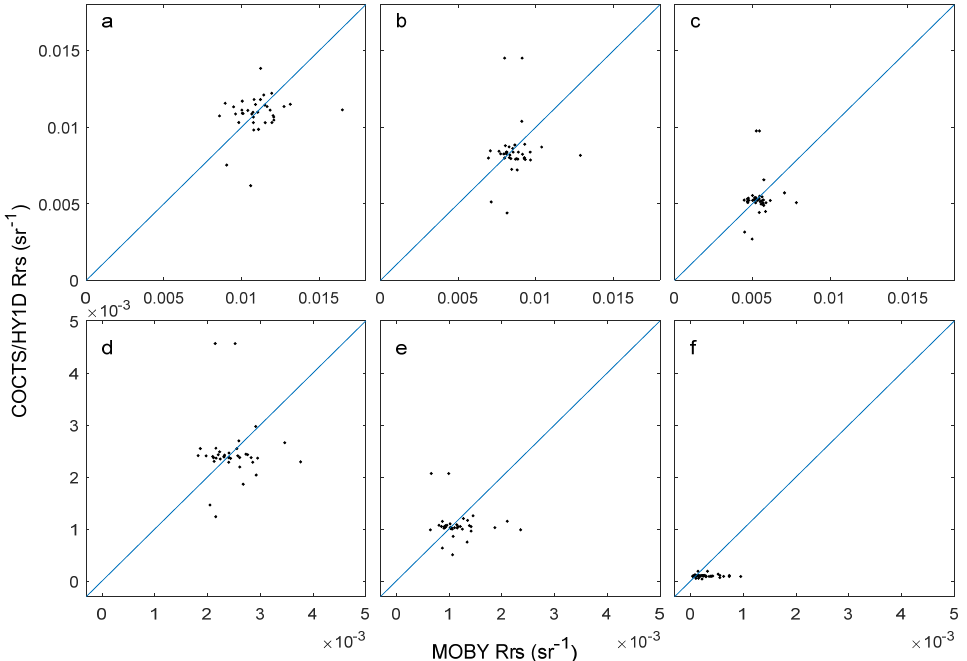
Figure 3. The comparison of R rs between the COCTS/HY-1D and MOBY measurements on the same day. Subfigures ( a – f ) represent the values in Bands 1–6, respectively.